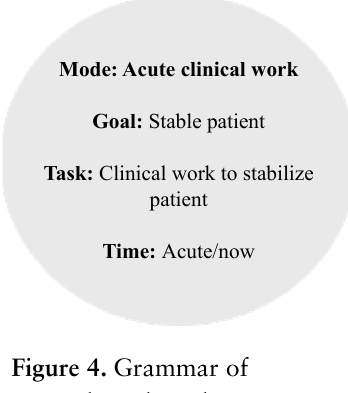
Figure 4. Grammar of acute clinical work.